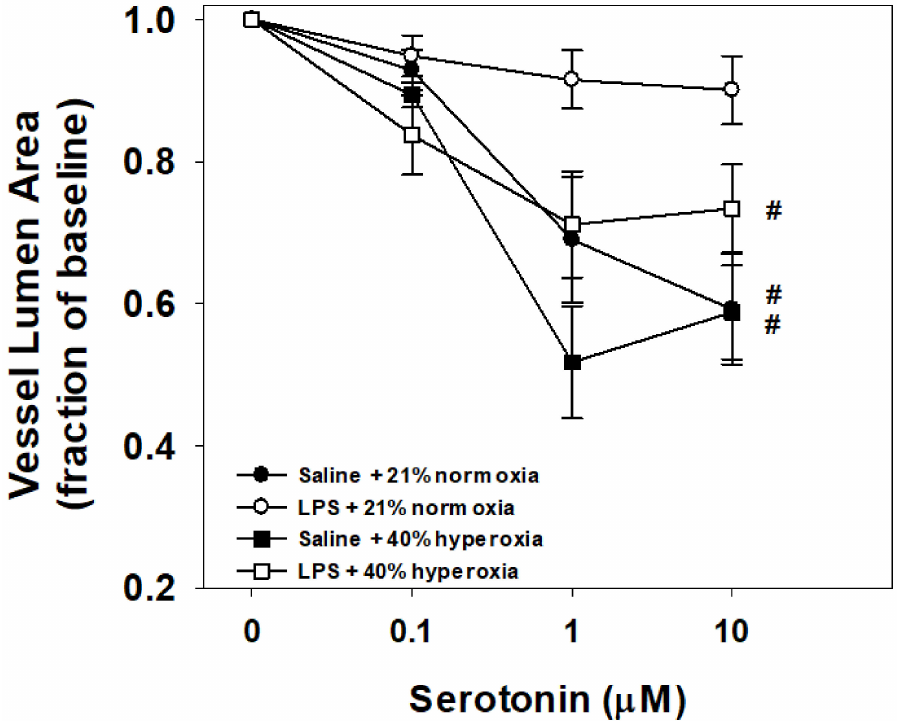
Figure 3. Vessel responses to serotonin challenge in the in vitro living lung slice preparation from 21-day-old mice. PCLS vessel responses to increasing doses of bath-applied serotonin in mouse pups that received one week of neonatal (P1–7) hyperoxia (squares) or normoxia (circles) and were born from pregnant dams that received an i.p. injection of saline (filled symbols) or LPS (open symbols) at E18 stage of pregnancy. Vessel reactivity of control (saline + normoxia; filled circles), hyperoxia alone (filled squares), and LPS with hyperoxia (open squares) did not significantly differ between groups. Prenatal maternal LPS alone (open circles) significantly attenuated vessel reactivity compared to all groups. Values are the means ± 1SEM. Significant differences in the dose response to serotonin: #vs. LPS+normoxia ( p <